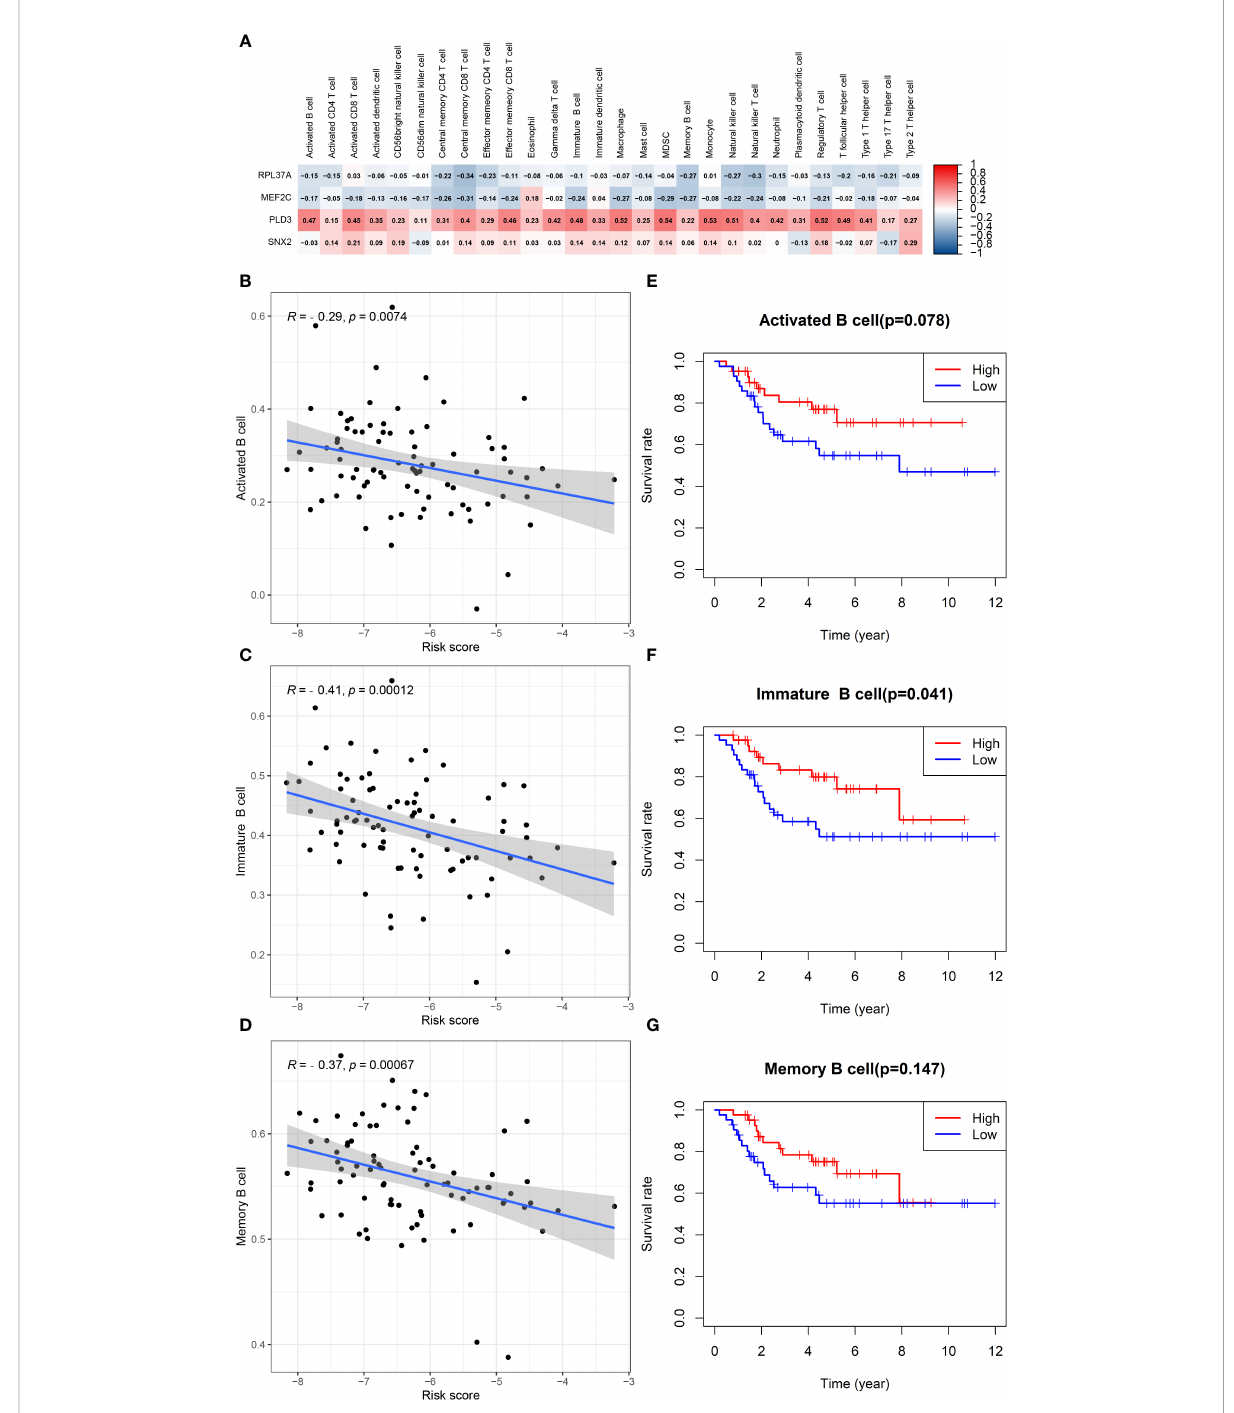
FIGURE 7 B cells in TCGA data in relation to prognosis. (A) Heatmap depicting the correlation between 4-gene mRNA expressions with the 22 immune cells. (B – D) Correlation fi tted curves of risk scores with activated B cells, immature B cells, and memory B cells. (E – G) Survival curves grouped by median content of activated B cells, immature B cells and memory B cells,